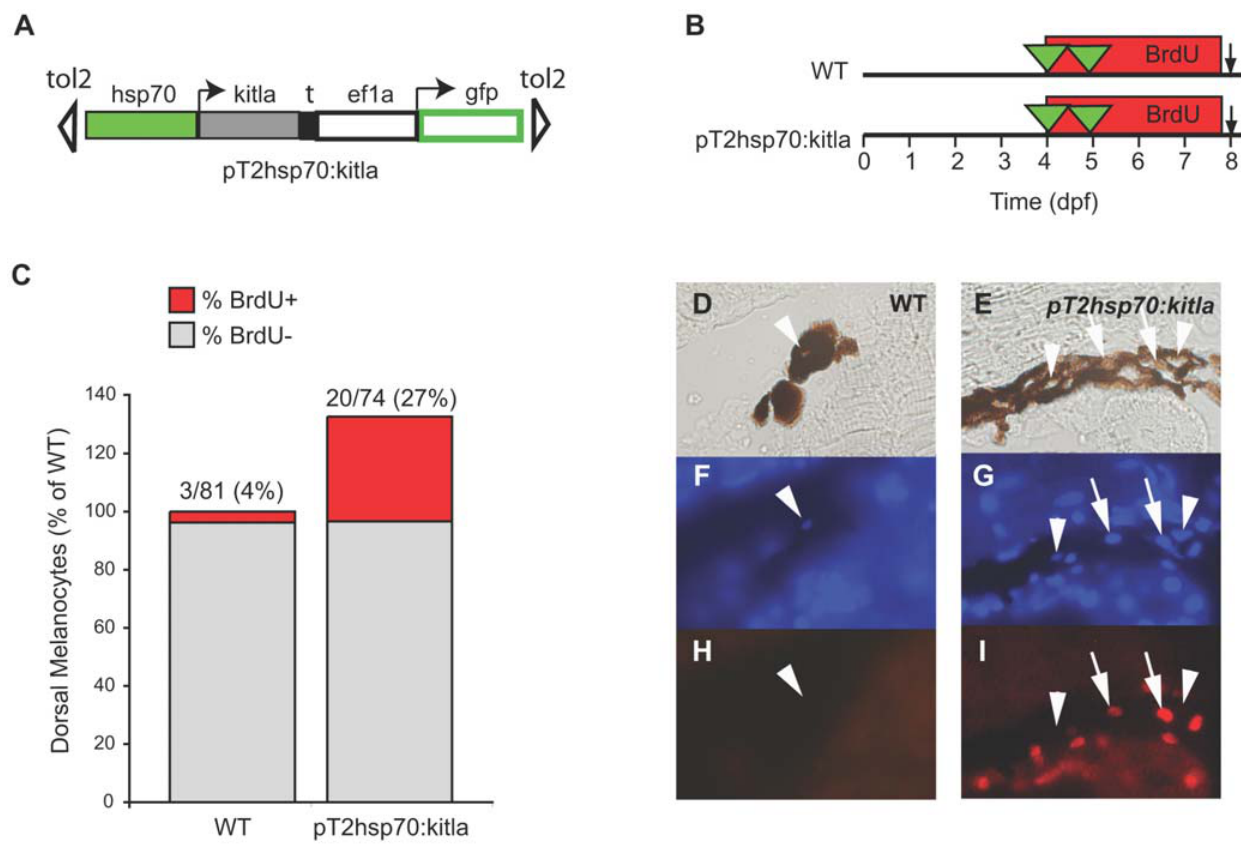
Figure 5. Overexpression of kitla after 4 dpf results in proliferation of melanocytes. (A) Cartoon of the pT2hsp70:kitla expression construct used in heatshock experiments. The heatshock promoter, hsp70 drives kitla expression, allowing for expression of kitla after heatshocking the injected embryos at 37 u C. (B) Cartoon of experimental protocol. Following injection of pT2hsp70:kitla , larvae were heatshocked for 1 hour at 4 and 5 dpf in the presence of BrdU (from 4 to 8 dpf). (C) Quantitation of dorsal melanocytes represented as a percentage of wild type, and the percentage of BrdU labeled melanocytes is represented in red for each treatment. Larvae injected with pT2hsp70:kitla and heatshocked develop approximately 30% more melanocytes than uninjected larva. These larvae also show an increased percentage of BrdU labeled melanocytes ( , 27%) that is comparable to the number of excess melanocytes. Representative examples of melanocytes in WT (D, F, H) and pT2hsp70:kitla (E, G, I), showing melanocyte nuclei stained with DAPI for WT (F) and pT2hsp70:kitla (G), and BrdU staining for WT (H) and pT2hsp70:kitla (I). Melanocytes considered having BrdU + nuclei are labeled with arrows and BrdU- nuclei are labeled with arrowheads.